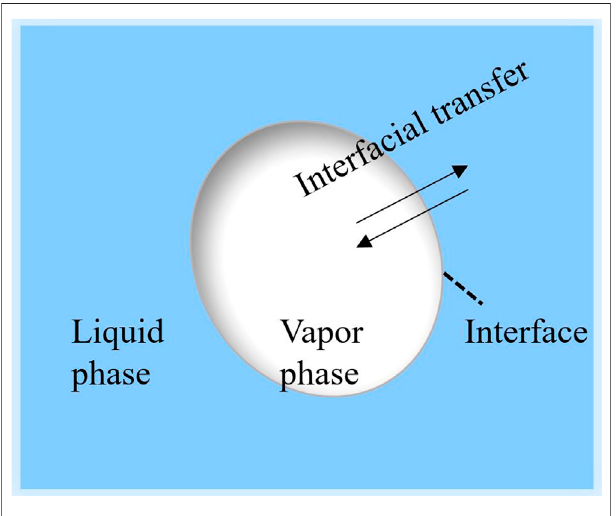
FIGURE 1 | The interfacial mass, momentum, and energy transfer through the interface between liquid and vapor phase.